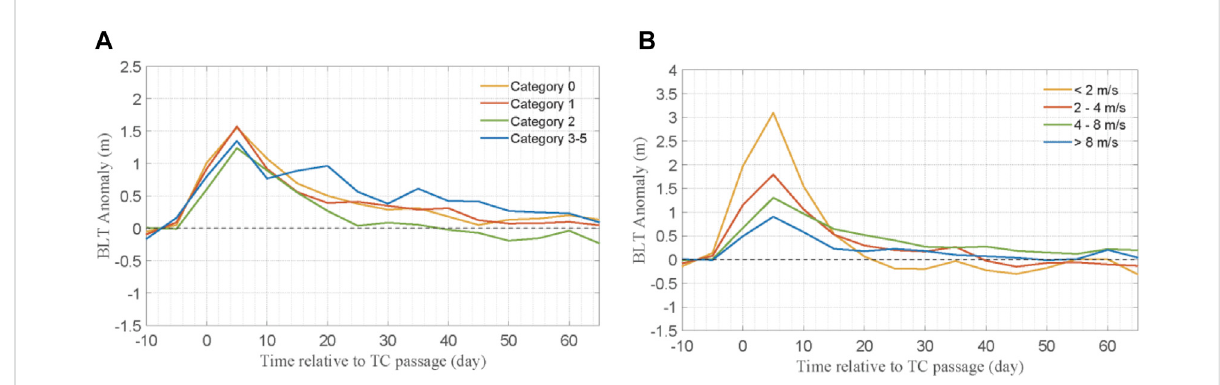
The recovery process of BLT anomaly under different TC categories (A) and under different TC translation speeds (B) in 65 days. Category 0 – 5referstoatropicaldepression,tropicalstorm,severetropicalstorm,typhoon,severetyphoon,andsupertyphoon,respectively(same asFigures 3,